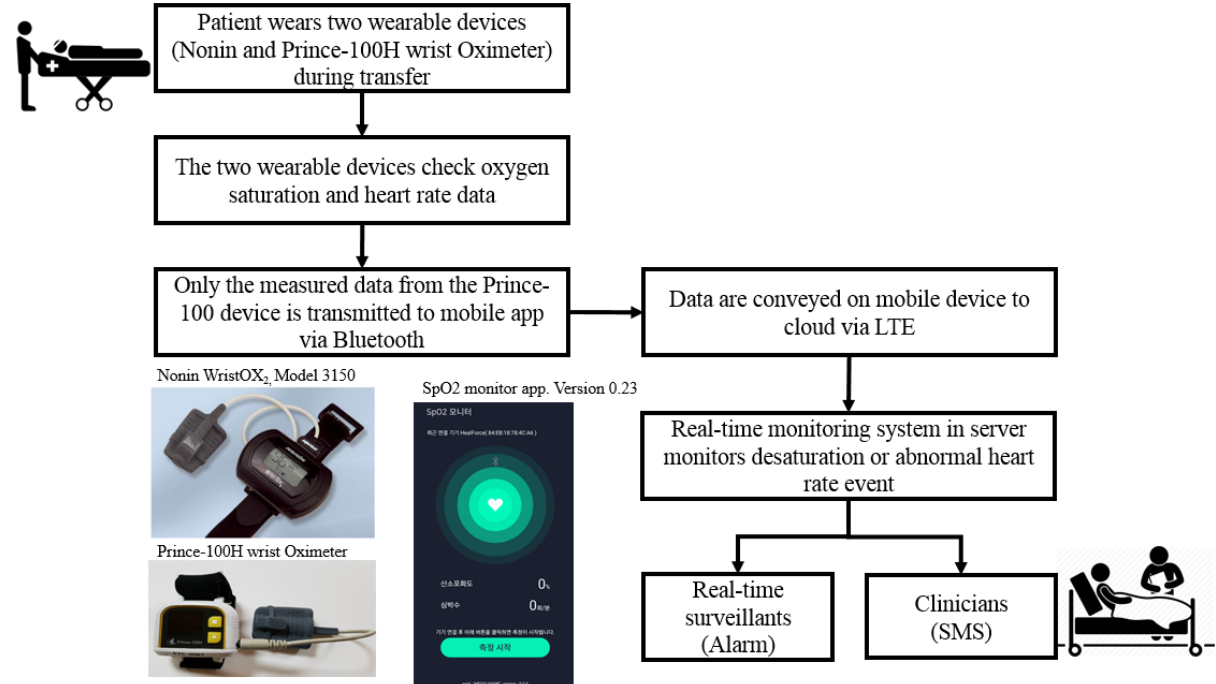
Figure 1. Data flow for risk signal detection system during patient transfer through wearable device and a mobile